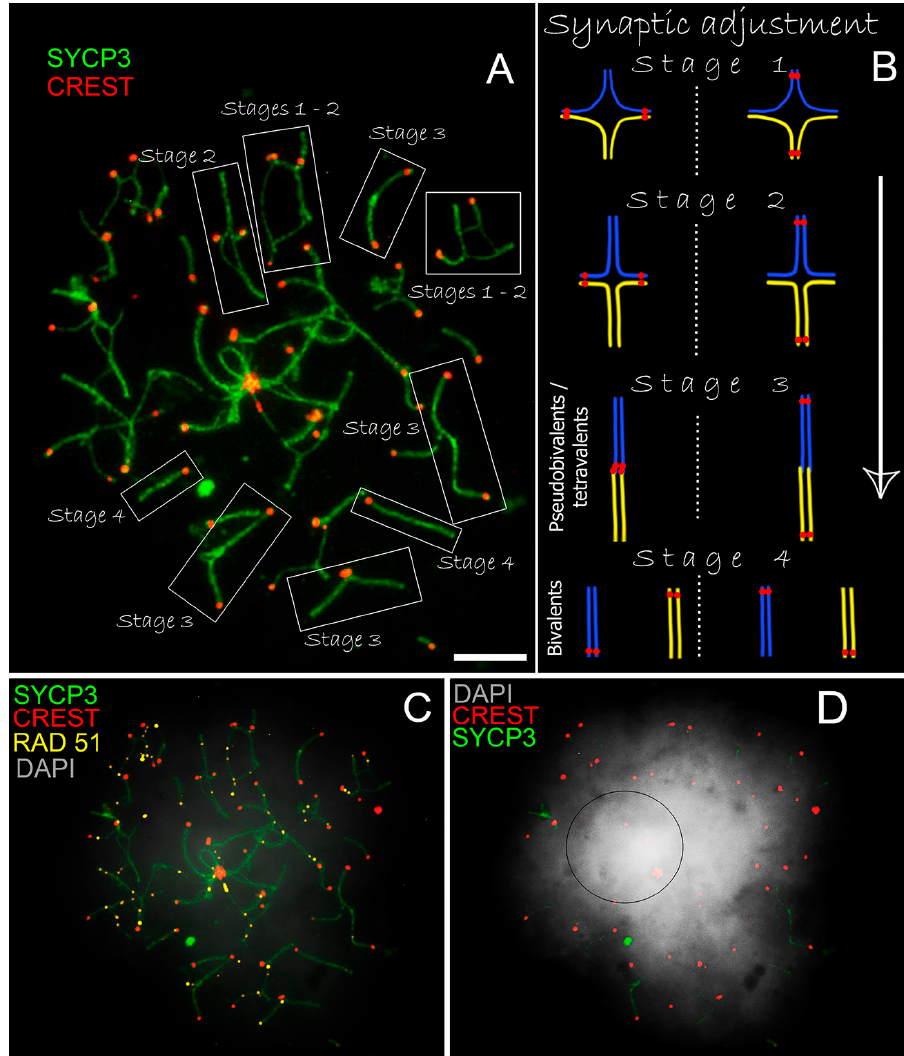
Figure 4. Tetraploid early pachytene spermatocyte from E. talpinus with stable karyotype (2n = 54, NF = 54). Axial SC elements were identified using anti ‐ SYCP3 antibodies (green), anti ‐ CREST for kinetochores (red), DNA double ‐ strand break (DSB) loci immunostained with antibodies against the RAD51 protein kinetochores (red), DNA double-strand break (DSB) loci immunostained with antibodies against the (yellow). Chromatin was stained with DAPI (gray). Pseudo ‐ bivalents (tetravalents) at the different stages RAD51 protein (yellow). Chromatin was stained with DAPI (gray). Pseudo-bivalents (tetravalents) of synapsis were in the nuclei ( A ). Four homologous adjusted sequentially, forming double